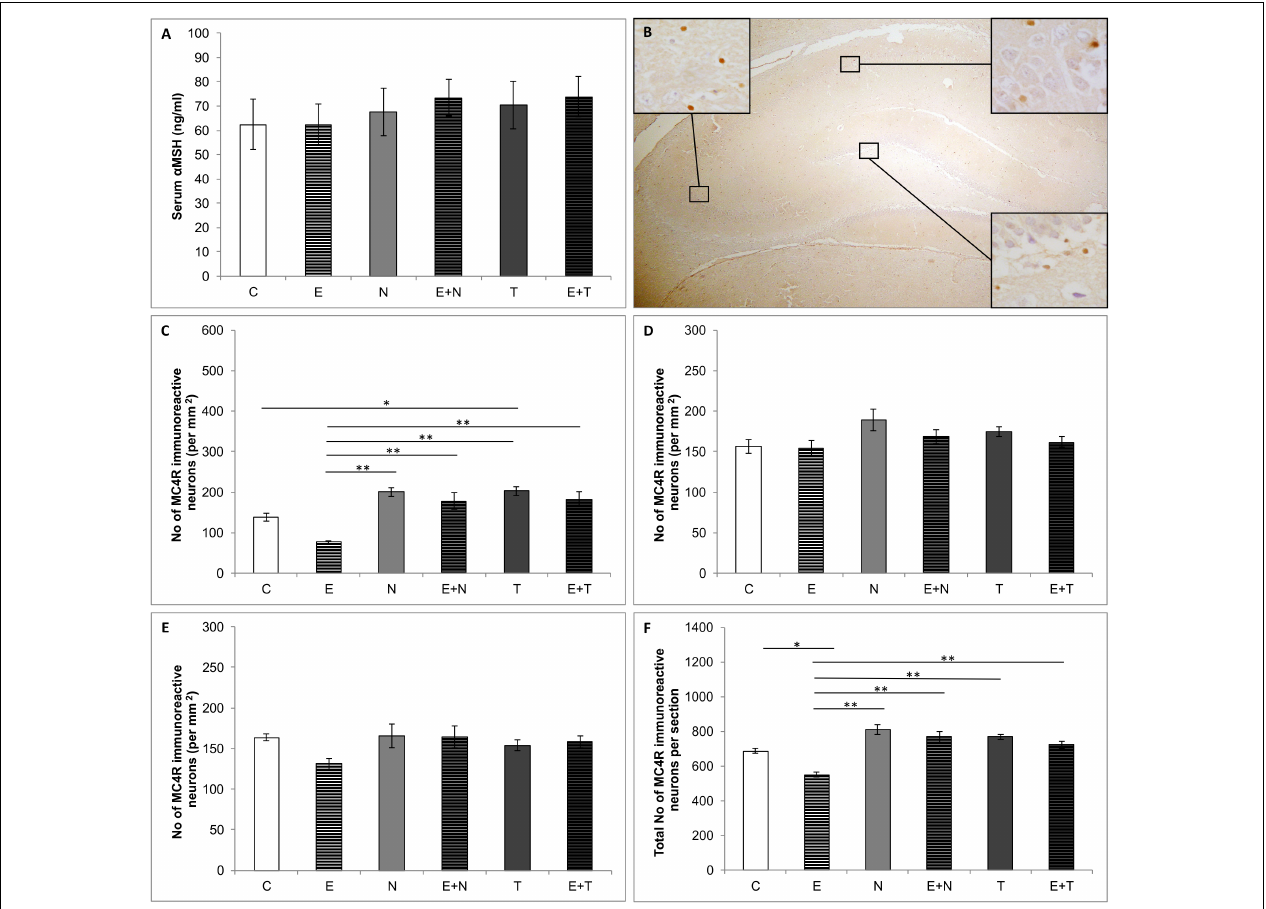
FIGURE 4 | Serum α MSH and hippocampal MC4R content. (A) Serum α MSH levels; (B) Distribution of immunoreactive MC4R neurons in hippocampus; (C–F) Number of MC4R immunoreactive neurons in CA1 (C) , CA2/3 (D) , DG (E) and total hippocampal section (F) ; (C, control group; E, exercise group; N, nandrolone-decanoate group; E+N, exercise plus nandrolone-decanoate group; T, testosterone-enanthate group; E+T, exercise plus testosterone-enanthate group). Bars represent means ± SEM, ∗ denotes a significant difference p ≤ 0.025, ∗∗ denotes a significant difference p ≤